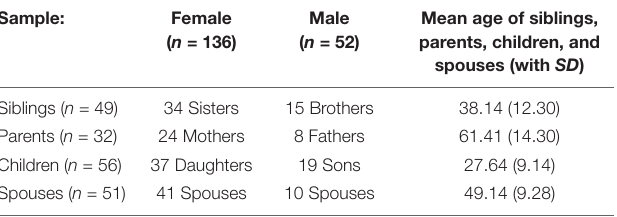
TABLE 1 | Samples of participant groups in questionnaire study.